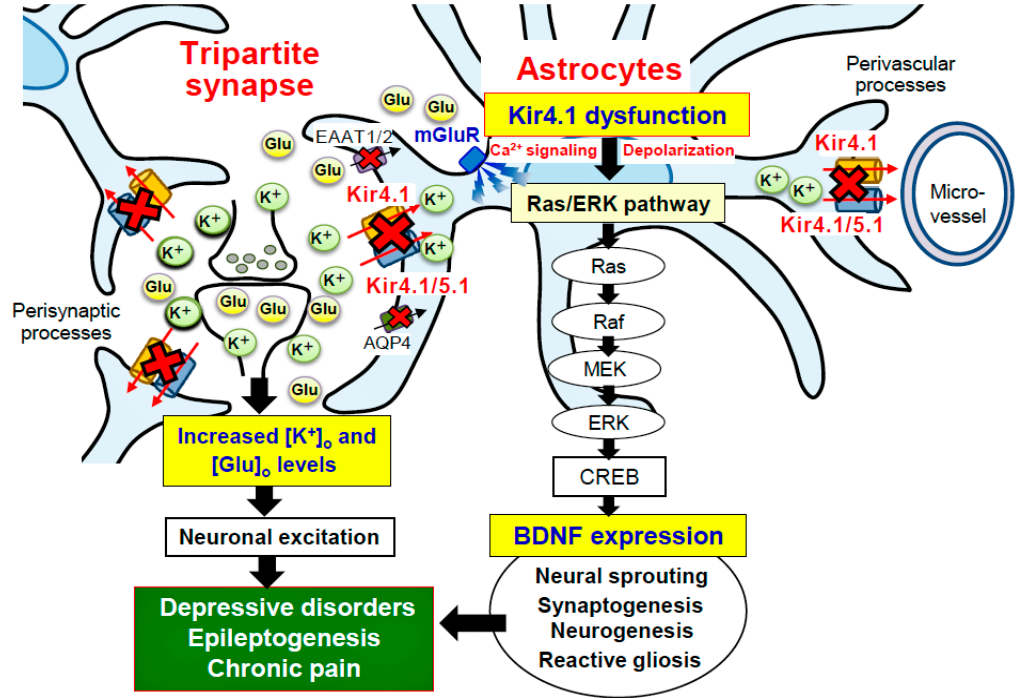
Figure 6. Schematic diagram showing the effects of Kir4.1 inhibition on neuronal excitability and astrocytic BDNF expression. Inhibition (e.g., gene mutation, reduced expression, and pharmacological blockade) of Kir4.1 channels increases the [K + ] o and [Glu] o levels at synapses and elevates neural excitability. Kir4.1 inhibition also activates the Ras/Raf/MEK/ERK signaling pathway and enhances BDNF expression in astrocytes, facilitating neural sprouting, synaptogenesis, neurogenesis and reactive gliosis. Through these influences, Kir4.1-containnng channels seem to play crucial